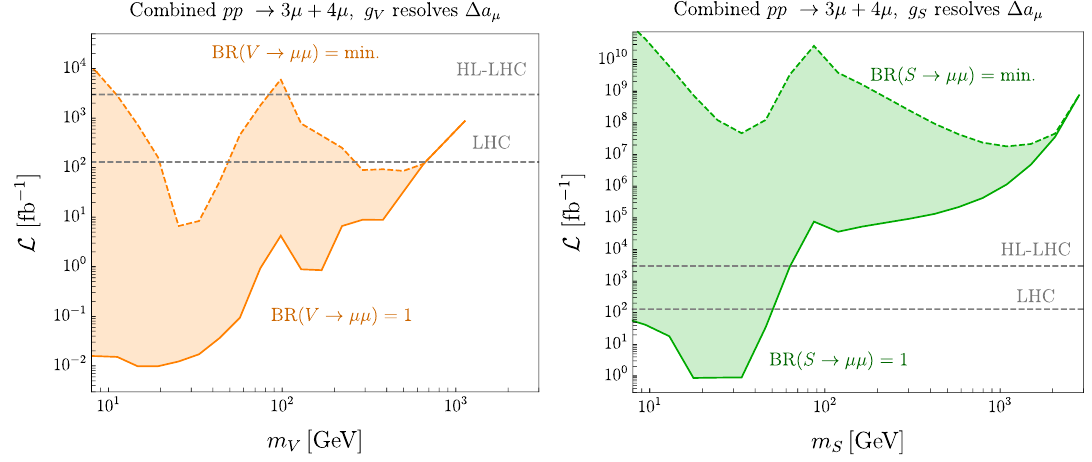
Figure 8 . LHC luminosity required to exclude vector (left) and scalar (right) singlet models at 2 sigma via a resonant singlet search in the 3+4 µ channel, for singlet couplings set to resolve the ( g − 2) anomaly. The upper dashed curves corresponds to the minimum singlet branching fraction µ to muons, see eqs. (2.5) and (2.11). The lower solid curves correspond to singlets decaying entirely to